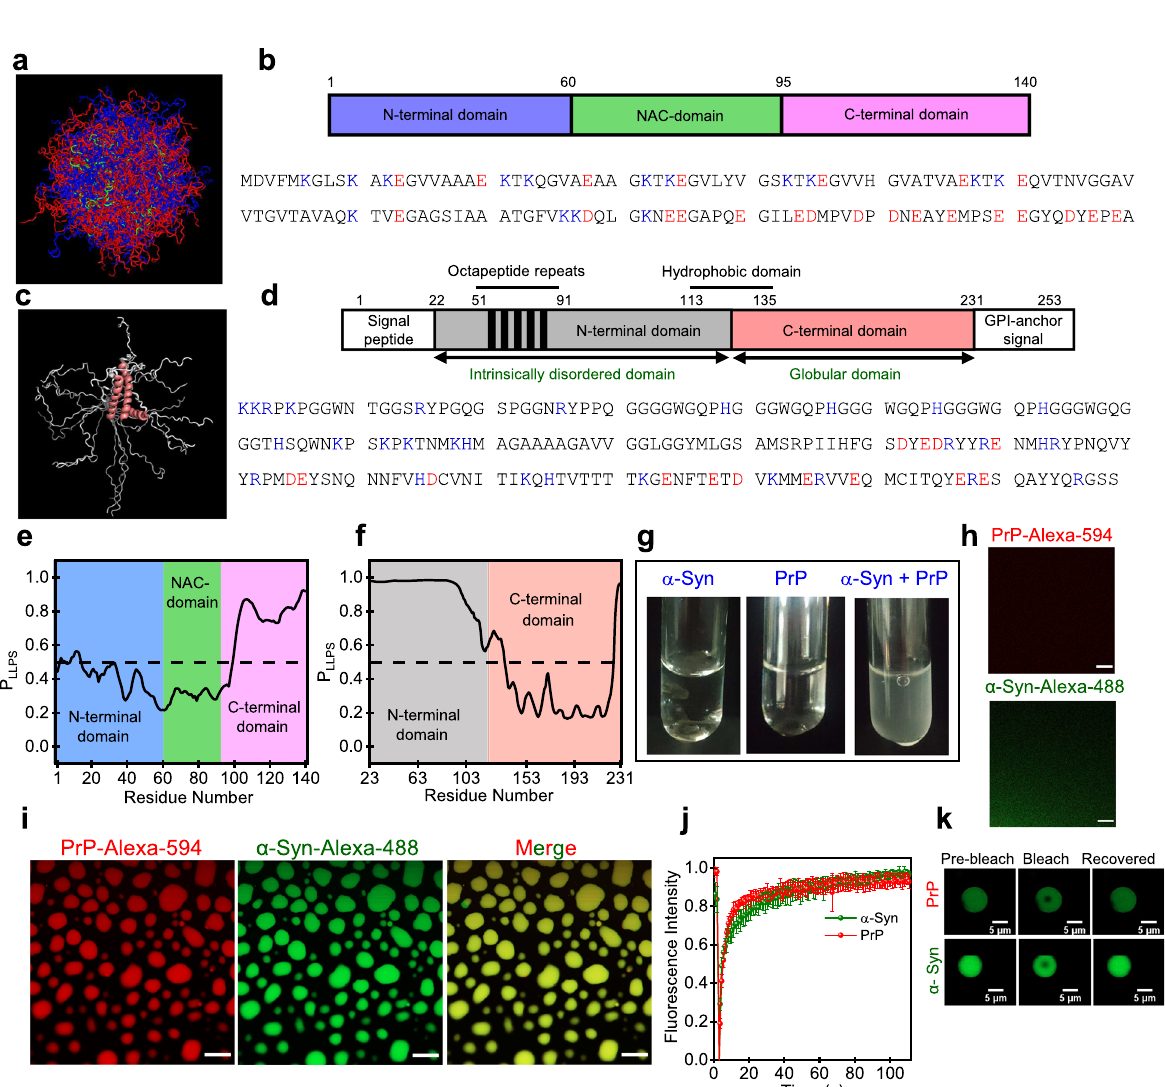
Fig. 1 Heterotypic phase separation of α -Syn and PrP. a An overlay of 576 conformations obtained from the ensemble structure of α -Syn (PED ID: PED00024e001) generated using PyMOL (Schrödinger, LLC, New York). b Domain architecture and the amino acid sequence of α -Syn. Positively and negatively charged amino acids are shown in blue and red, respectively. c An overlay of 20 conformations obtained from the NMR structure of human PrP (90 – 231) (PDB ID: 2LSB) generated using PyMOL. d Schematic representation of PrP (23 – 231) indicating the N-terminal disordered and the C-terminal globular domains. Positively and negatively charged amino acids are shown in blue and red, respectively. Prediction of the LLPS propensity using FuzDrop for e α -Syn and f PrP (23 – 231). g LLPS upon mixing of homogenous solutions of α -Syn (45 µ M) and PrP (30 µ M) at pH 6.8 at 37 °C. h , i Confocal images of mixed homogeneous phases of PrP and α -Syn and complex coacervates of PrP (red) and α -Syn (green) performed using Alexa-594-labeled PrP (Cys 31) and Alexa-488-labeled α -Syn (Cys 90) indicating their complete colocalization (yellow) within droplets (Scale bar: 10 µ m). See Supplementary Movie 1 for droplet fusion events. j FRAP kinetics of multiple droplets (~1% Alexa-488-labeled protein) for PrP (red) and α -Syn (olive). The FRAP experiments were performed using Alexa-488-labeled α -Syn and PrP independently. The data represent mean ± s.d for n = 5 independent experiments. Source data are provided as a Source Data fi le. k Fluorescence images of droplets during FRAP measurements. PrP and α -Syn concentrations were 20 and 30 µ M, respectively. See Methods for details. The imaging was performed thrice with similar observations ( h , i , k